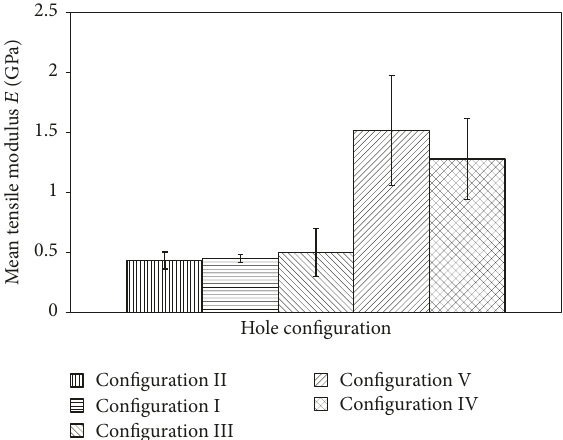
Figure 7: Tensile modulus of lontar fiber-reinforced composites with different hole configurations.